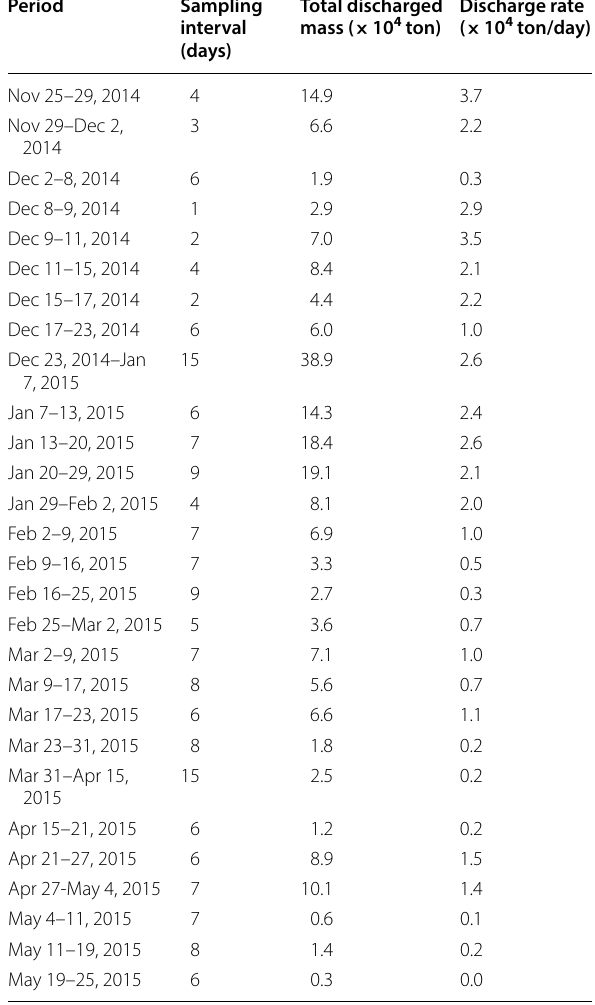
Table 1 Mass of tephra discharged during the November 2014–May 2015 activity of Nakadake first